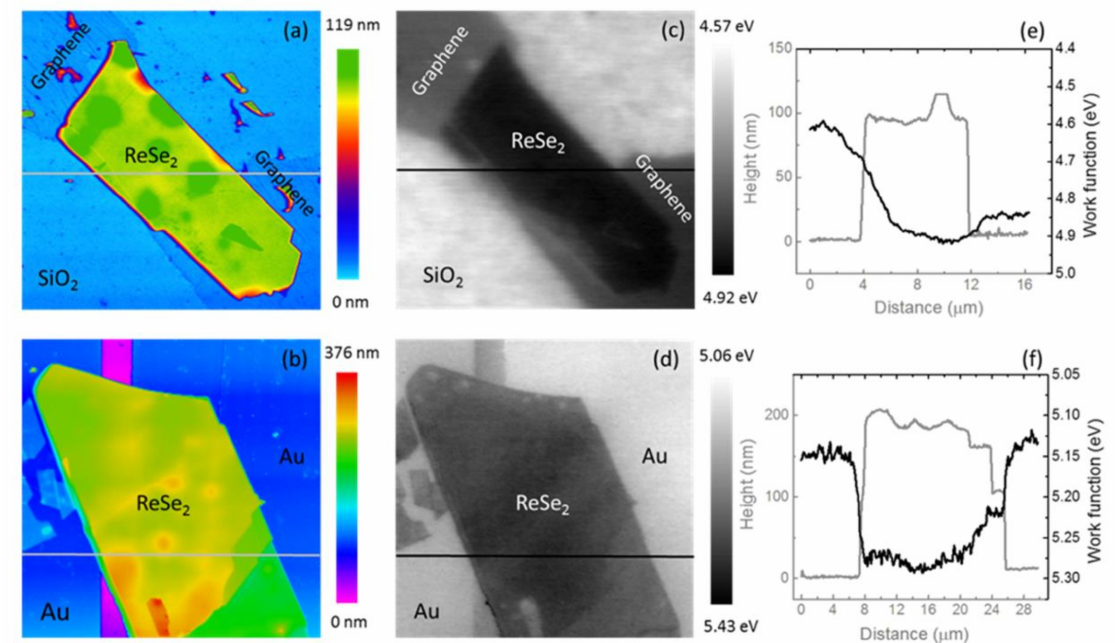
Figure 5. KPFM characterization of ReSe 2 devices. ( a , b ) Tapping mode topography (16.5 µ m × 16.5 µ m and 30 µ m × 30 µ m) of ReSe 2 /graphene/SiO 2 and ReSe 2 /Au. ( c , d ) Surface work function maps of the two devices. ( e , f ) Height and work function line profiles were obtained along the indicated gray and black solid lines. The right axis represents the absolute value of the work